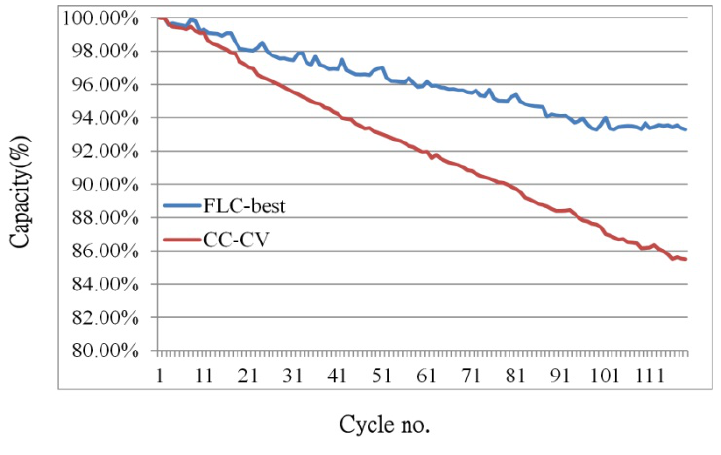
Figure 14. Comparison of cycle life test between the proposed charger and the CC-CV